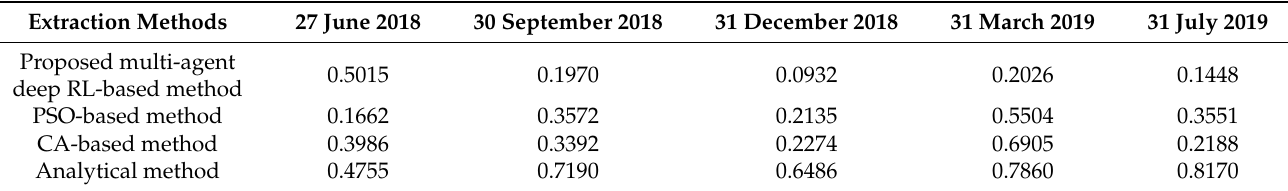
Table 2. Daily average RMSE (A) in typical days for different extraction methods.